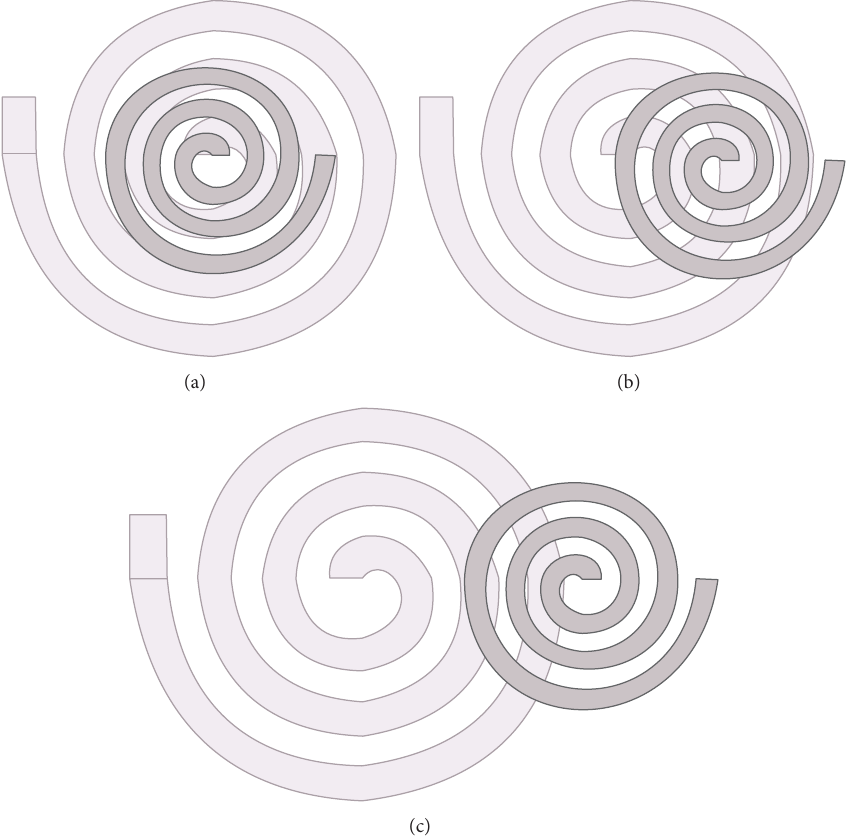
Figure 15: Misalignment between coils: (a) 0mm, (b) 5 mm, and (c) 10mm.